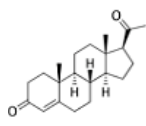
Figure 1. Chemical structure of progesterone and